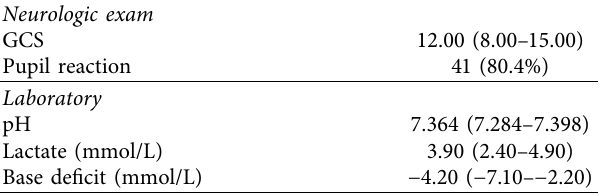
Table 2: Neurological examination and laboratory findings.